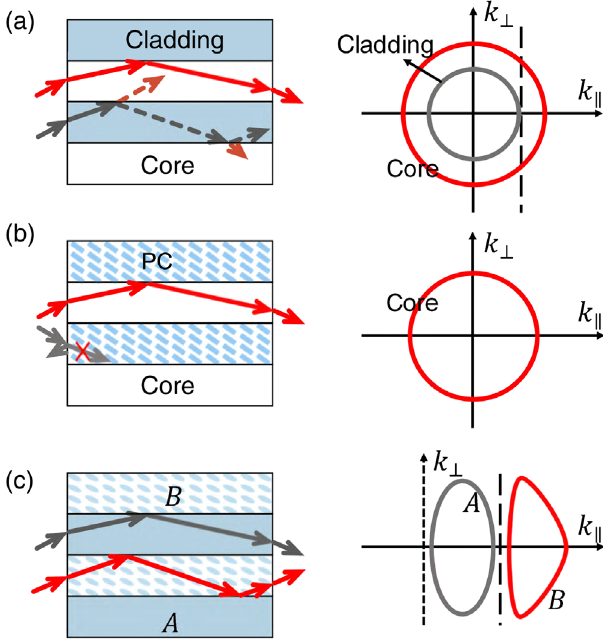
FIG. 1. Principles of traditional waveguide arrays and ZSWAs. The schematic diagrams of (a) traditional optical waveguides and (b) traditional PC waveguides that both require cladding layers and (c) ZSWAs with zero interchannel separation. The right panels demonstrate the equal frequency contours of the wave- guide Figure 1 schematically demonstrates the fundamental difference between the traditional optical waveguide arrays, PC waveguide arrays, and the scheme of ZSWAs without cladding layers. The left panels show the schematics of transmission processes, and the right panels show the equal frequency contours (EFCs) of the materials comprising the waveguides. Here, k k and k ⊥ denote the wave-vector components in the parallel and vertical directions of the waveguides, respectively. For waveguide modes, k k equals to the propagation constant β . In optical waveguide arrays [29], low-index cladding layers confine the waves inside the high-index core layers, as the β ð k k Þ of the waveguide modes is larger than the wave number of the cladding layers (the dashed line). In PC waveguide arrays, waves can be confined in the core channels of an arbitrary index, e.g.,